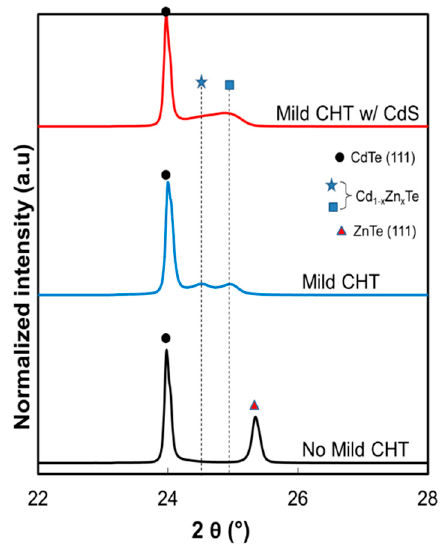
Figure 8. XRD patterns of ZnTe:As back contacted CdTe thin film solar cell structures.